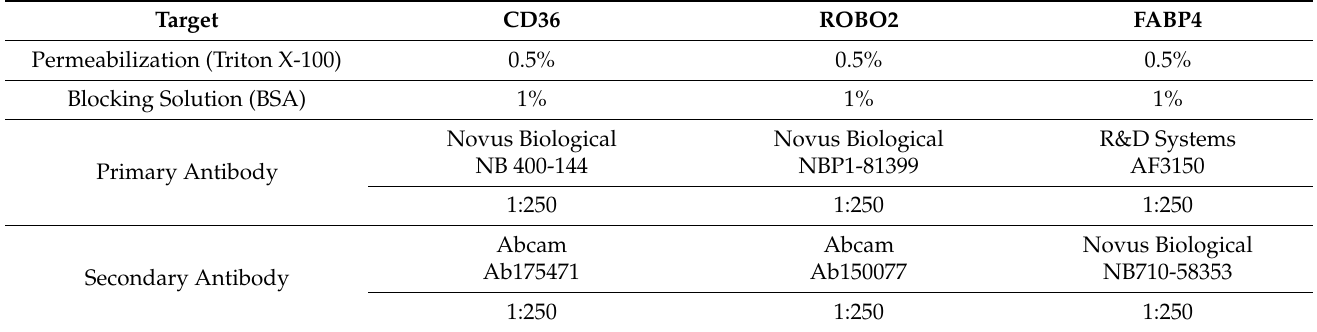
Table 1. Details of the immunofluorescent staining for each molecular